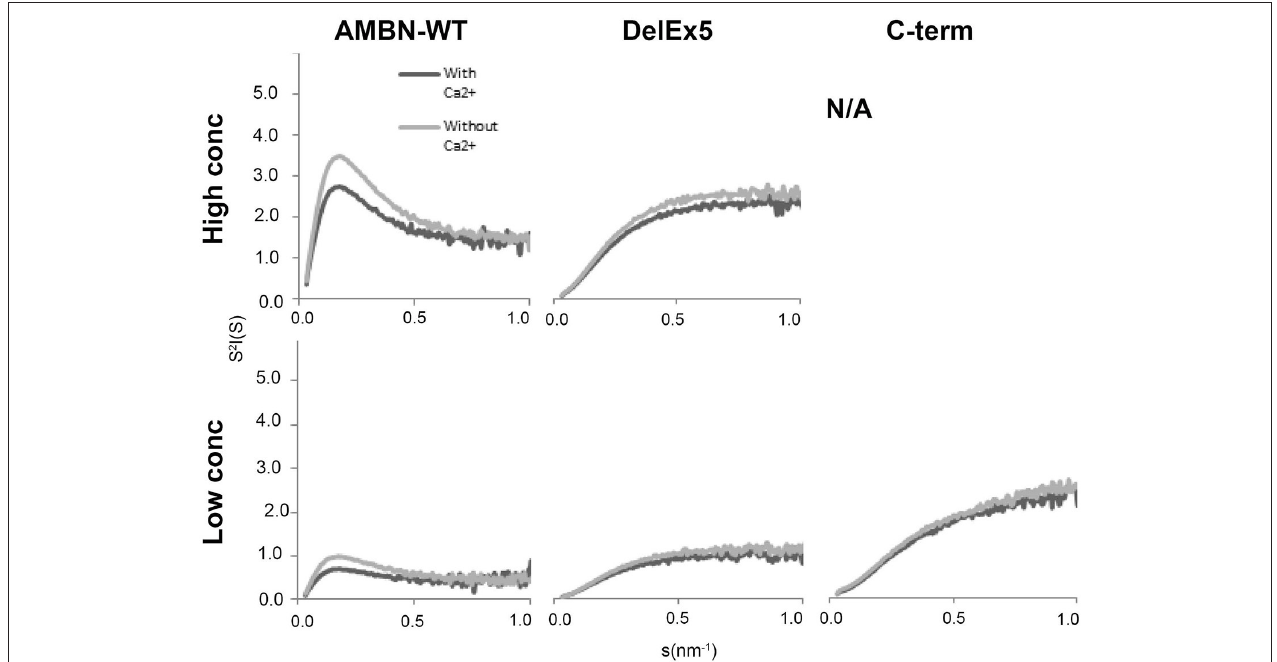
FIGURE 5 | Short Angle X-ray Scattering (SAXS) Kratky plots of AMBN-WT, DelEx5, and C-terminus with or without Ca 2 + . High concentration corresponds to 0.7, 0.88 mg/ml, and N/A, respectively, whereas low concentration corresponds to 0.4, 0.44, and 0.44 mg/ml, respectively. N/A means not analyzed due to lack of